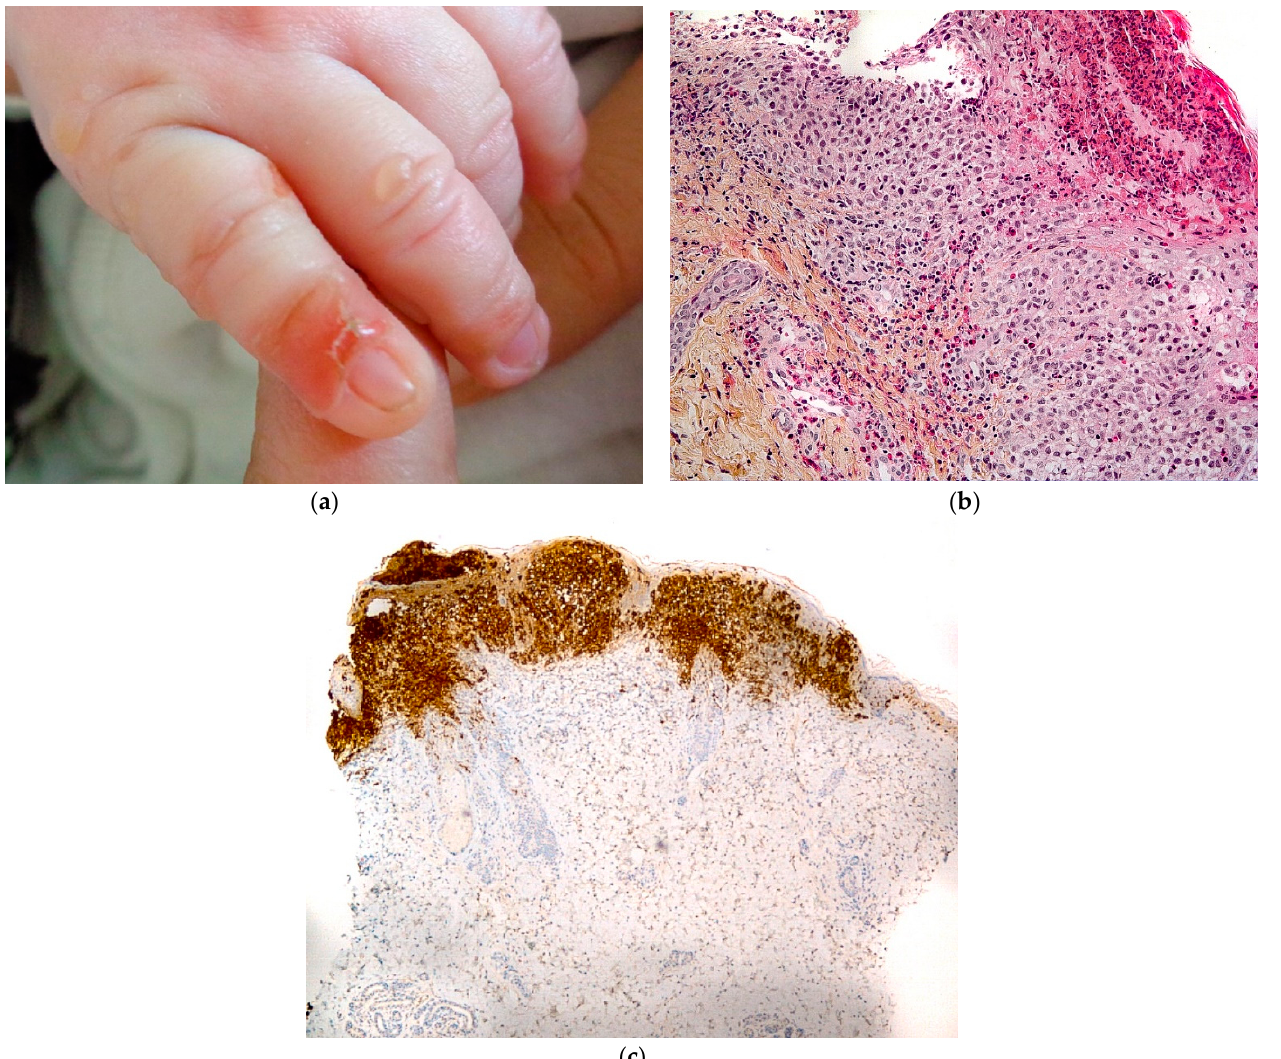
Figure 10. Langerhans cell histiocytosis. ( a ) Blister in a neonate. ( b ) Hematein eosin ×40: papillary infiltration with Langerhans cell, exocytosis resulting in blister and crusts, eosinophilic infiltrate in the dermis. ( c ) Immunohistochemistry with anti ‐ CD1a antibody ×5: positivity of the dermal infiltrate.